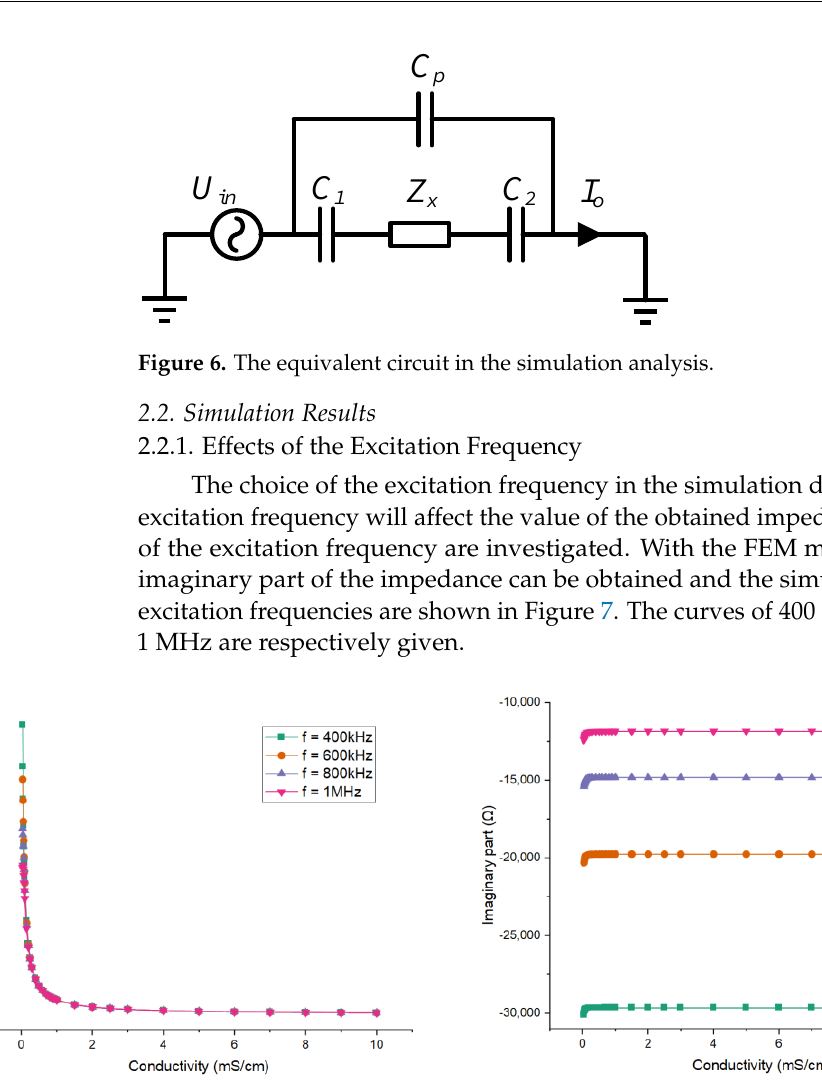
the imaginary part of the impedance.